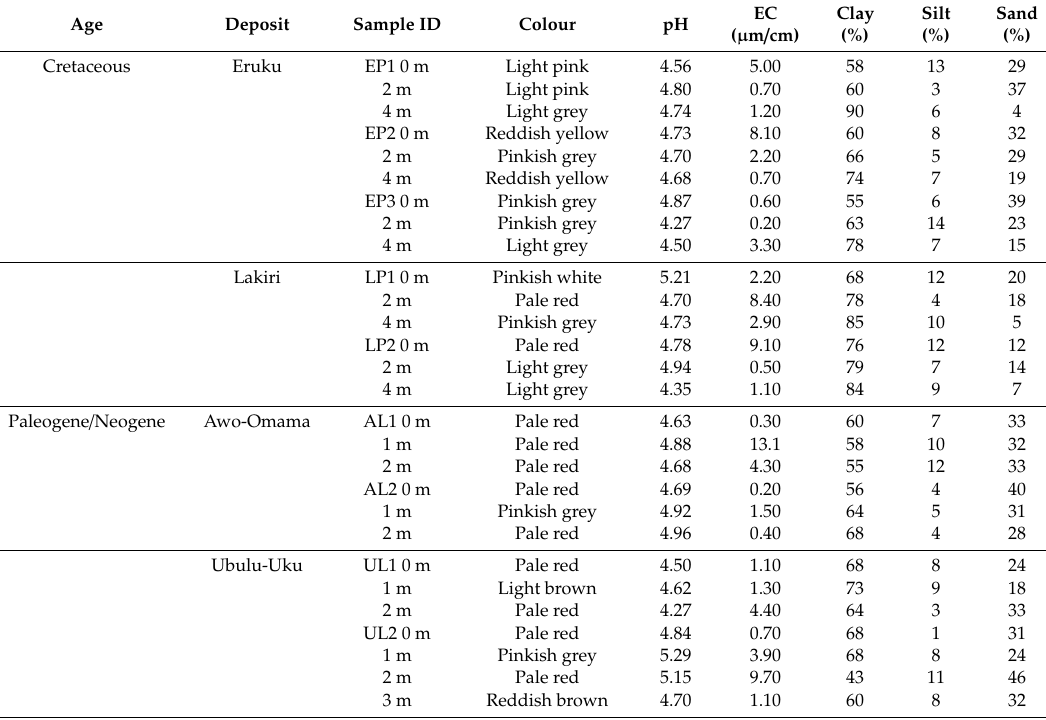
Table 2. Colour, pH, electrical conductivity (EC), and particle size distribution of the studied Cretaceous–Paleogene / Neogene